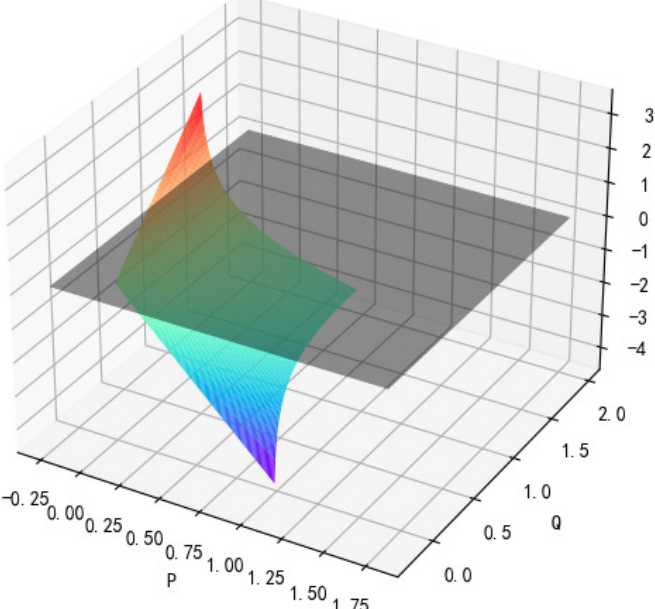
Figure 3. Image of the VTE algorithm.